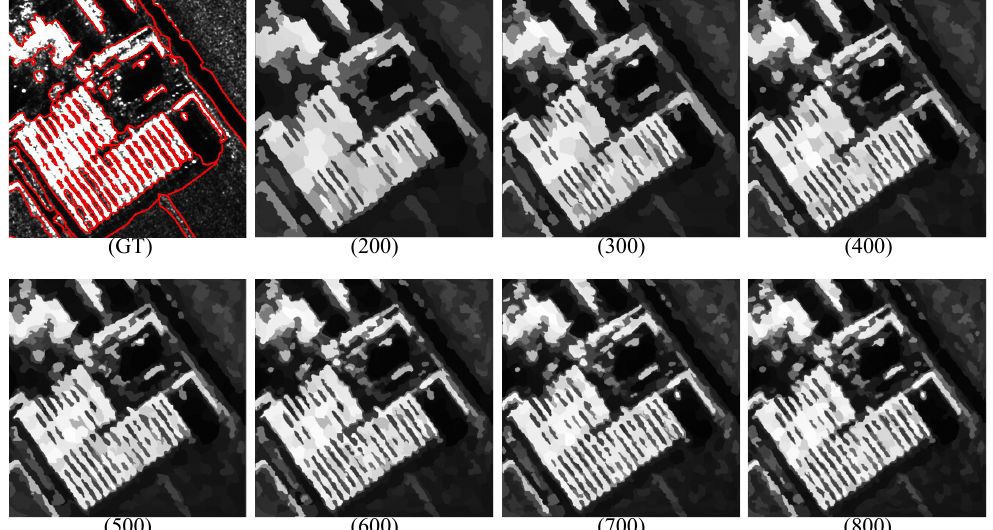
Figure 15. Superpixel results generated by the proposed method with different numbers of